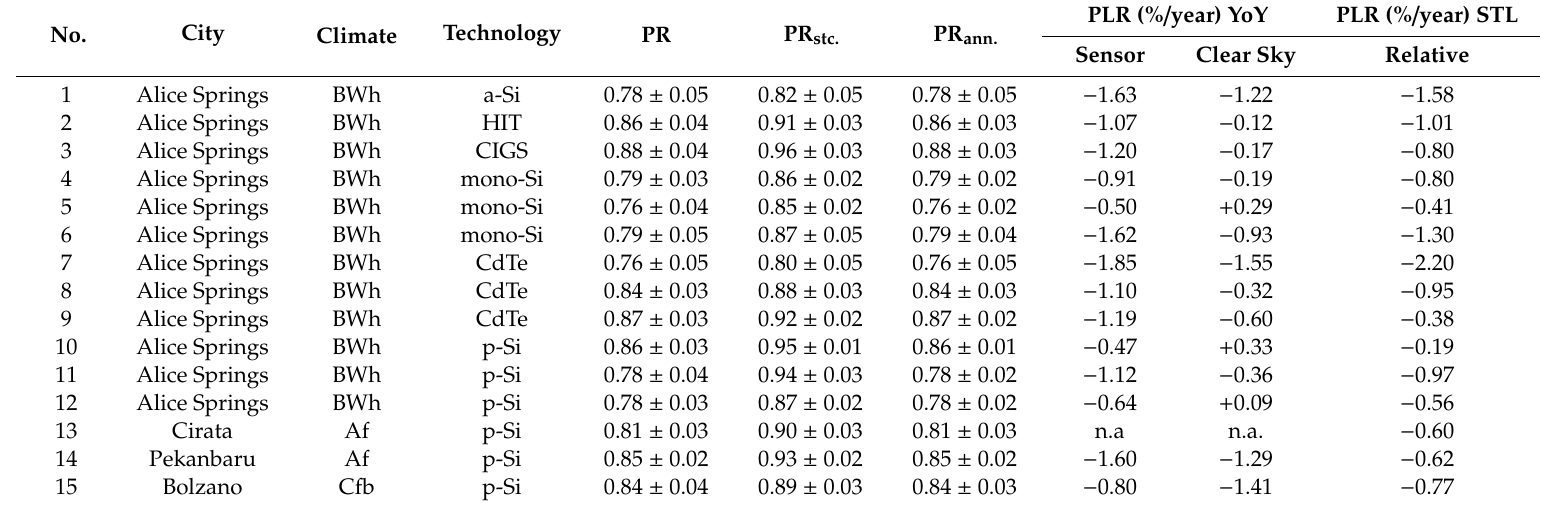
Table A1. The complete performance matrices of the PV